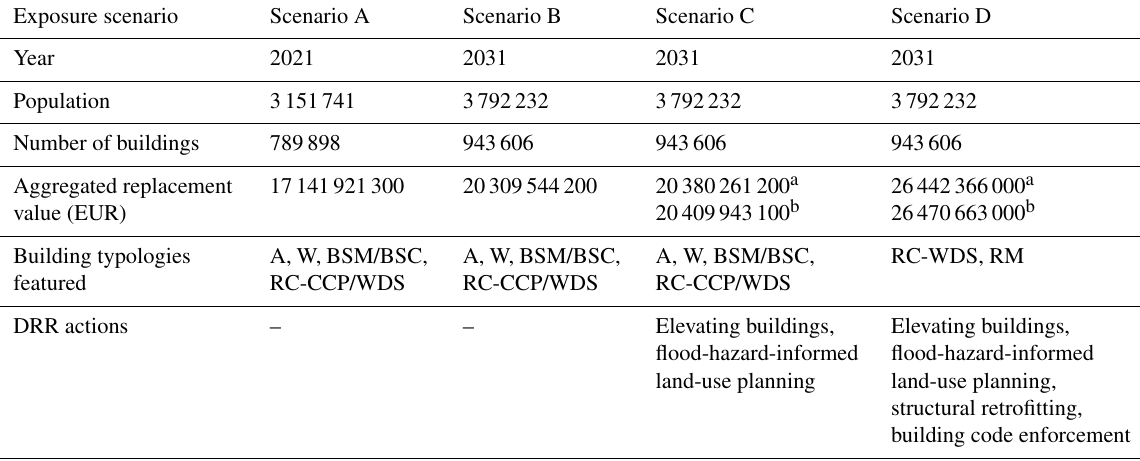
Table 1. Summary of considered exposure scenarios for Kathmandu